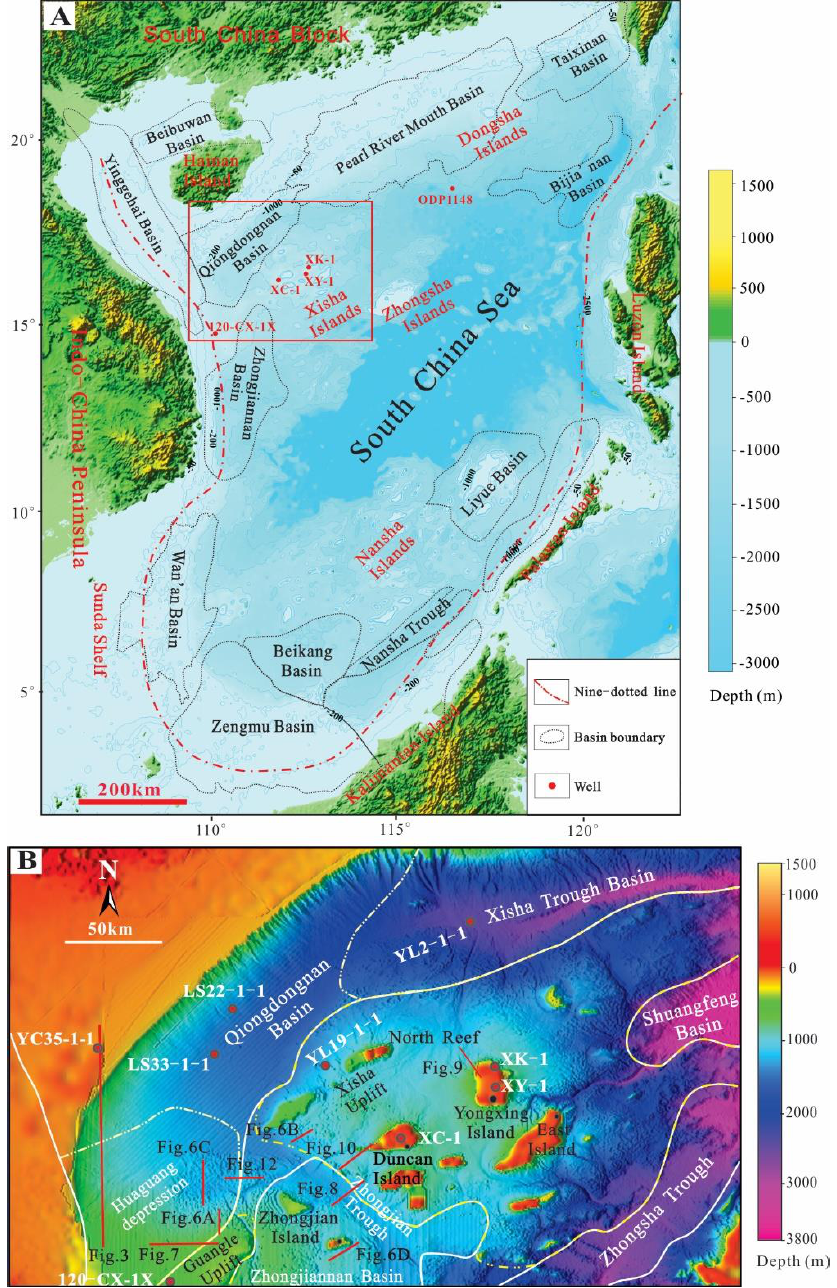
Figure 1. ( A ) Distribution of sedimentary basins and the study area in the northern South China Sea. The sedimentary basins are mapped with black dotted lines. The location of the study area adjacent to the Qiongdongnan and Zhongjiannan Basins is marked by the red rectangle. ( B ) Tectonic divisions of the study area and the locations of seismic lines and wells mentioned in the text. The red lines are the locations of seismic profiles showing different carbonate